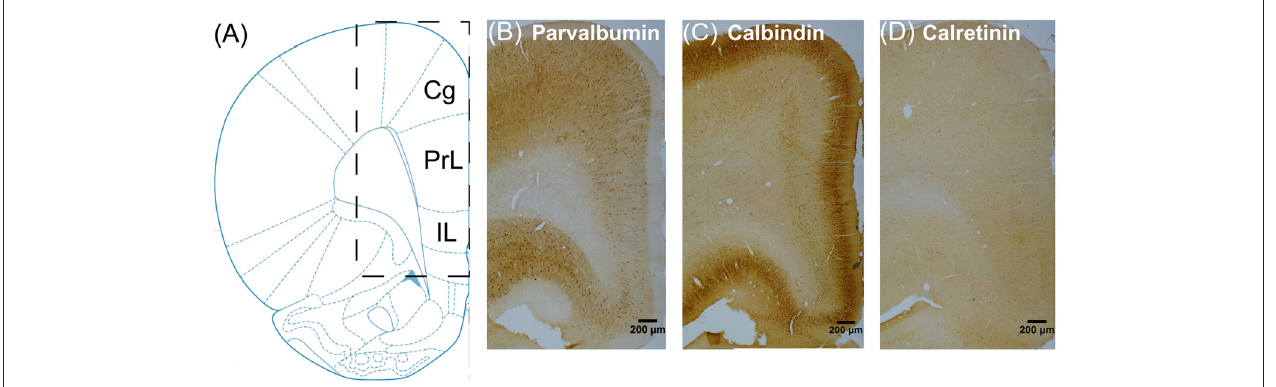
FIGURE 2 | Schematic of three subregions of rat medial prefrontal cortex (mPFC), including the cingulate cortex (Cg), the prelimbic cortex (PrL) and infralimbic cortex (IL), for immunohistochemistry analyses (A) and representative sections in the vehicle group immunostained for PV + (B) CB + (C) and CR + (D) neurons